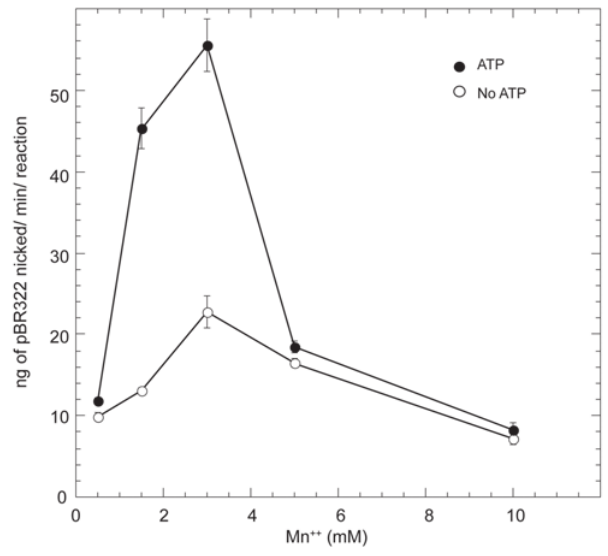
Figure 3. Effect of Mn ++ concentration on the Aae MutL nicking rate. Initial rate of Mn ++ induced nicking activity of MutL was measured in the presence (solid circles) or absence (open circles) of ATP at 37 u C. Different concentrations of Mn ++ were added to the buffer solution containing Aae MutL (6.4 m M). The amount of nicked plasmid was quantified with ImageJ software after resolving the different plasmid populations on a 1% agarose gel. Points were taken every 20 seconds for 2 minutes.